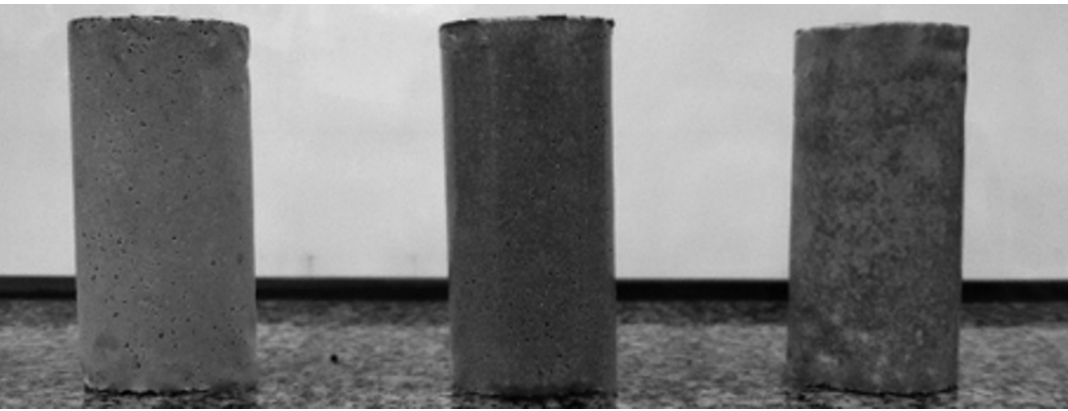
Figure 15. Specimens of the composites 50/50, 60/40 and 80/20 PET/T-GCW (from left to right).